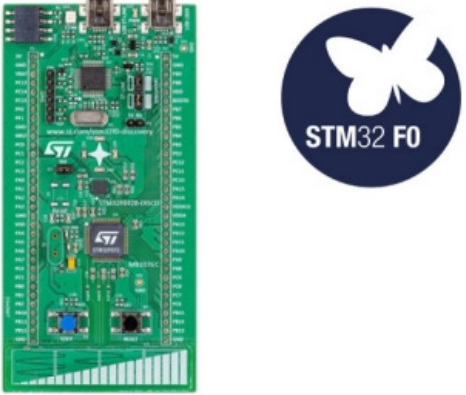
Figure 18. 32F072BDISCOVERY based on Cortex-M0 as the core. Sensors 2020 , 10 , x FOR PEER REVIEW